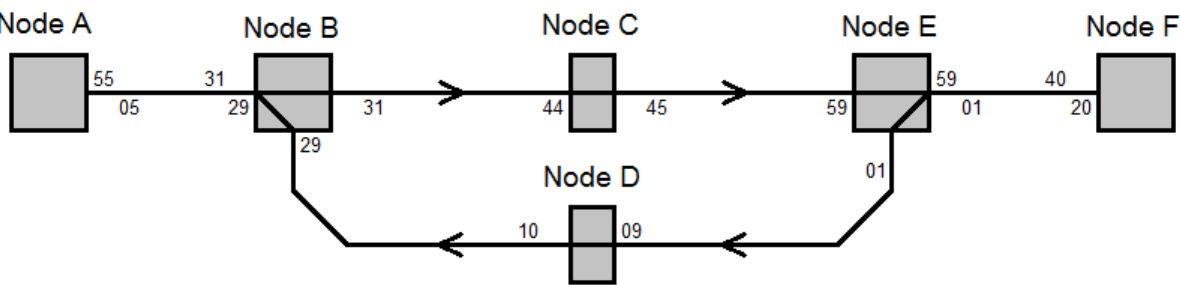
Figure 12. Operation of a public transport line in a certain direction only.